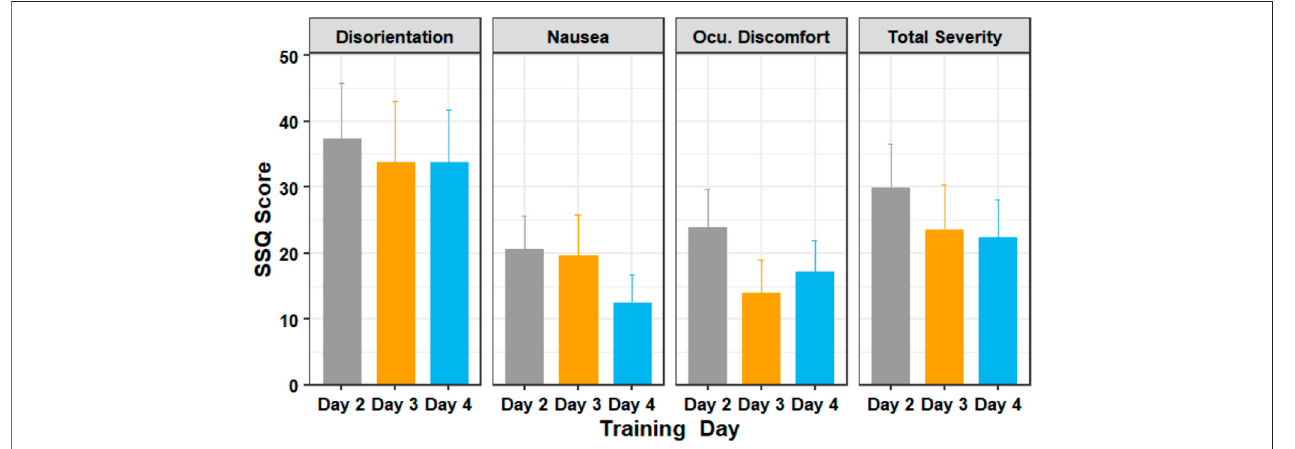
FIGURE 7 | The SSQ subscores of participants in days 2 through 4 of the training session. Figure shows mean and standard error.